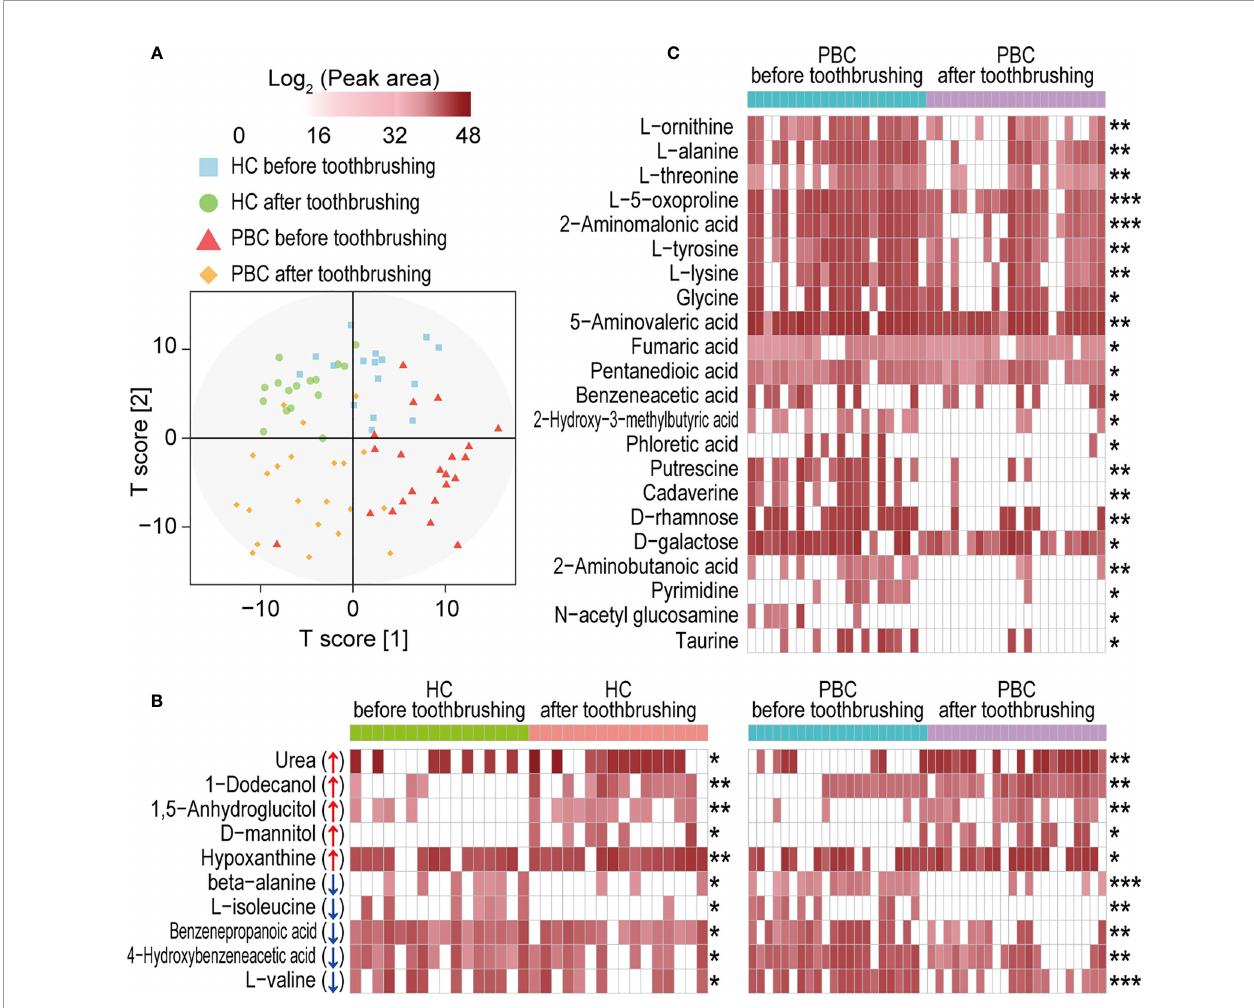
FIGURE 6 | Toothbrushing reduces the number of metabolites in PBC saliva more than that in HC saliva. (A) OPLS-DA plot of the salivary metabolome pro fi le in PBC and HC saliva before and after toothbrushing. (B) Metabolites that were signi fi cantly altered in both PBC and HC saliva from before to after toothbrushing. (C) Metabolites that were signi fi cantly altered only in PBC saliva from before to after toothbrushing. * P < 0.05; ** P < 0.01 and *** P <